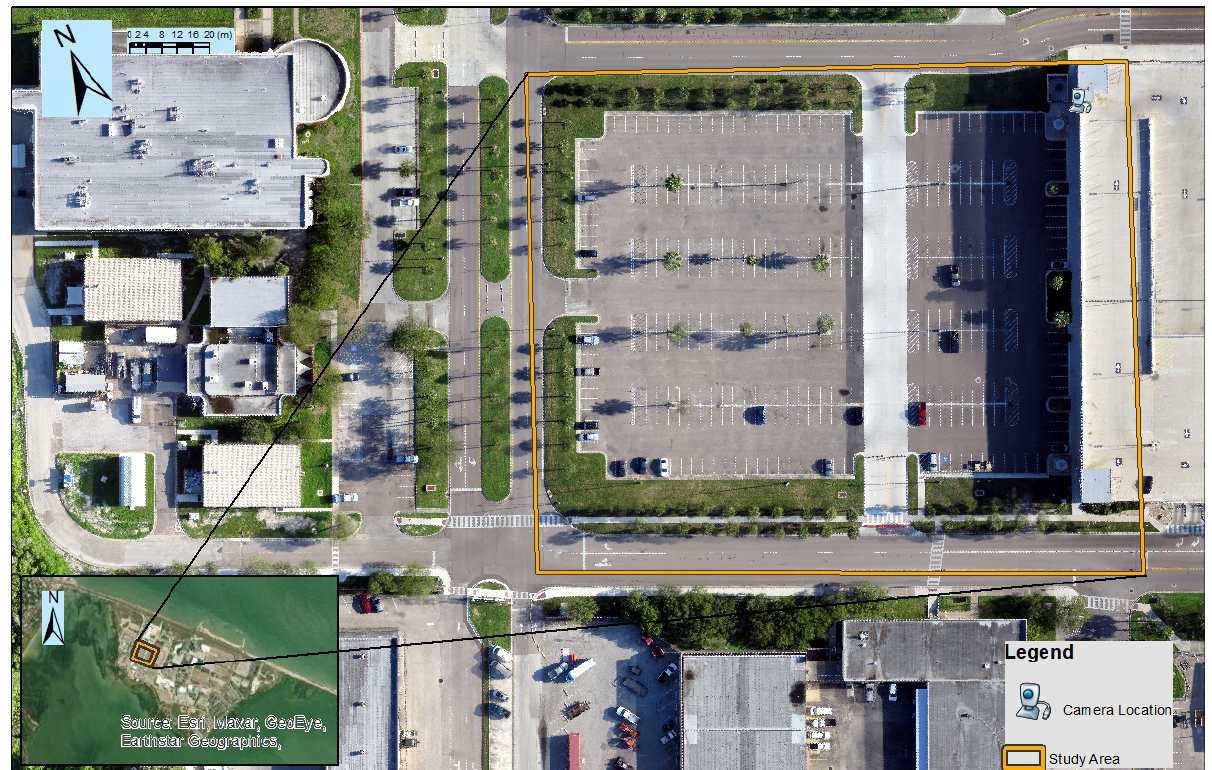
Figure 1. An example aerial UAS orthomosaic that provides the X, Y coordinates for monoplotting features which are combined with the Z values from the DSM to compute the registration between the perspective and aerial views. The parking lot of interest is outlined in orange, with an aerial map of the TAMUCC campus